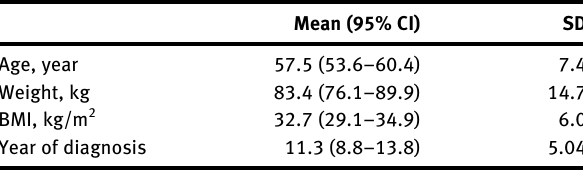
Table  : Baseline characteristics of